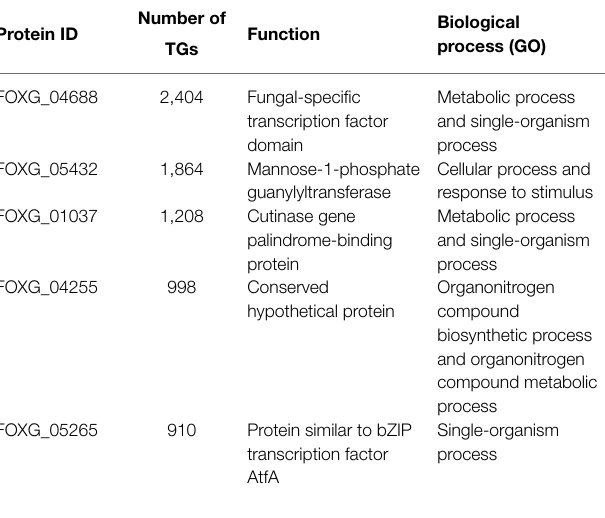
TABLE 3 | Top 5 identified hubs in the reconstructed